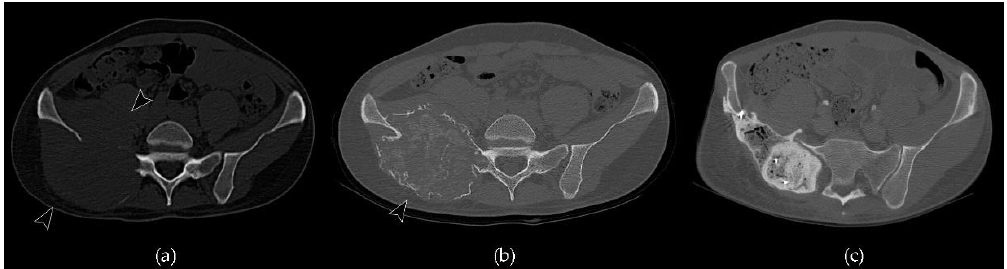
Figure 7. Axial CT scan of a case of GCTB of the sacrum and right iliac wing treated with denosumab and then subjected to surgical osteotomy: ( a ) a pre-treatment image shows an extensive osteolytic lesion, which extends to the adjacent soft tissues, involving the gluteal area and the pelvis (arrowheads); ( b ) a post-denosumab image demonstrates peripherical deposition of bone matrix with neocortex formation and intralesional osteosclerosis (arrowhead). A modest size reduction of the lesion can also be noted in relation to the shrinkage effect; ( c ) post-surgical evaluation highlights the outcomes of osteotomy in the right iliac wing filled with cement and two K-wires.